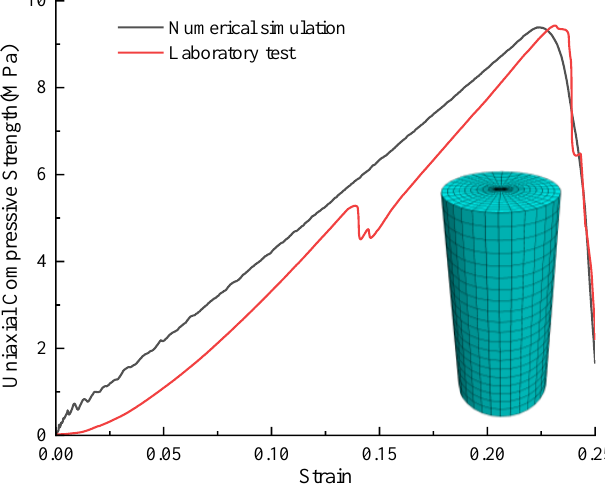
Figure 4. Comparison of stress – strain curves between numerical model and laboratory tests.